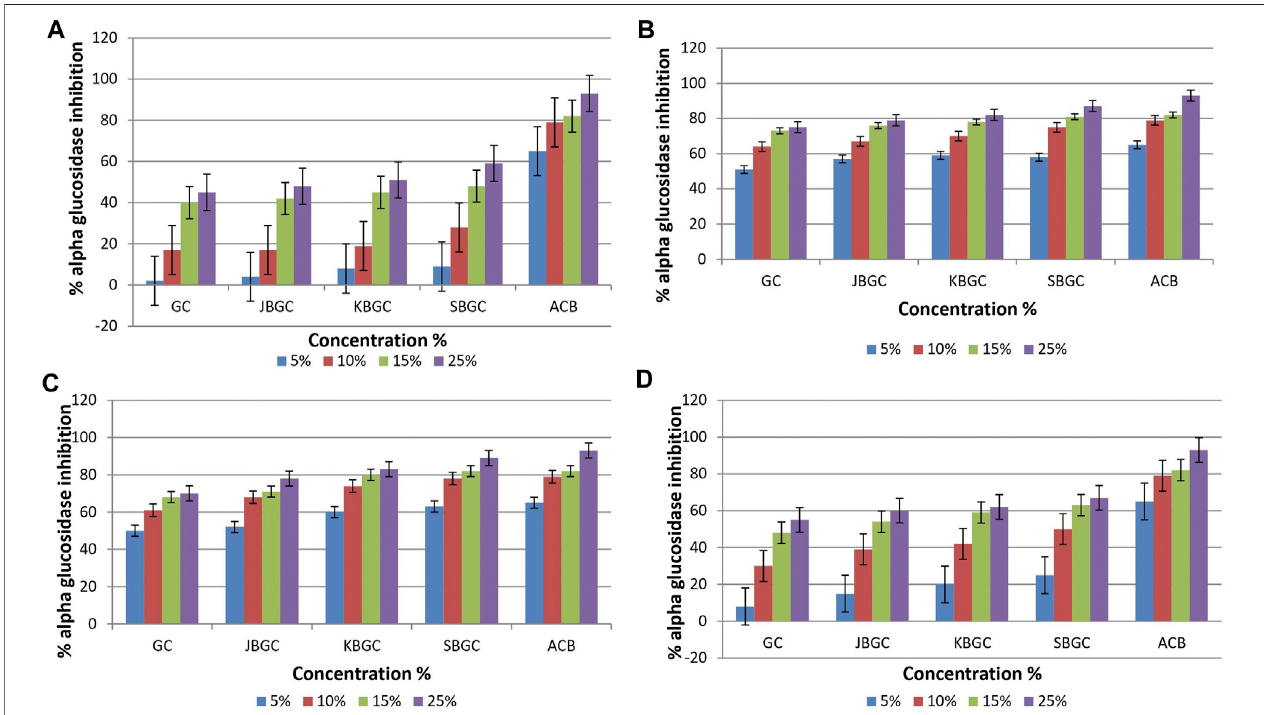
FIGURE3| α -glucosidaseinhibitoryactivityof GuduchiChurna (GC), SvarasaBhavitaGuduchiChurna (SBGC), KwathaBhavitaGuduchiChurna (KBGC),and Jala Bhavita Guduchi Churna (JBGC). (A) In phosphate buffer solution (PBS) (B) In dichloro methane (DCM) (C) In chloroform (D) In hexane.